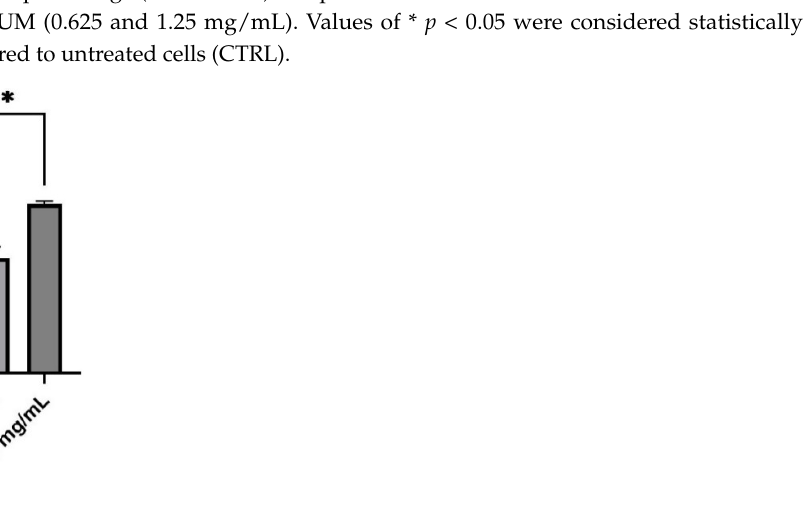
Figure 3. Collagen levels expressed as µg/mL (mean ± SD) after treatment with the RETINOIDS SERUM compared to control (CTRL, untreated cells). Values of ** p < 0.01 and *** p < 0.001 were considered statistically significant compared to CTRL (n = 3, replicates = 2).